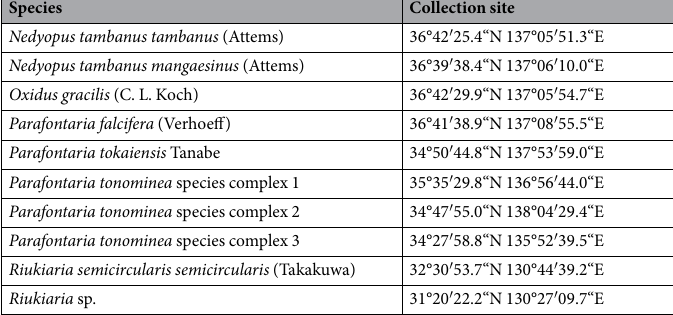
Table 1. Millipedes and their collection